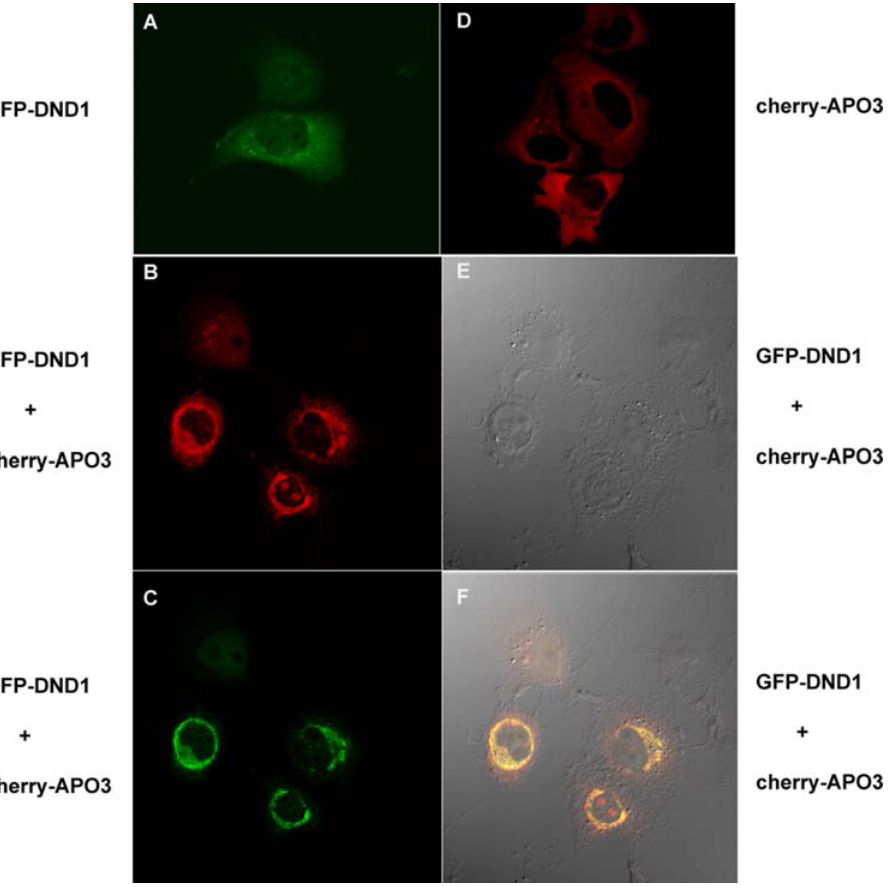
Figure 5. Mouse DND1 and APOBEC3 co-localize to peri-nuclear sites in the cell cytoplasm. (a) COS7 cells were transfected with expression constructs for GFP- Dnd1 for visualization of green fluorescence due to GFP-DND1. Cells were fixed with 2% paraformaldehyde before visualization of fluorescent signal by confocal microscopy. (d) COS7 cells were transfected with expression constructs for mCherry- Apobec3 for visualization of red fluorescence due to mCherry- Apobec3 by confocal microscopy. ( b,c,e and f) COS7 cells were co-transfected with expression constructs for GFP-DND1 and mCherry- Apobec3 . (b) Red fluorescence due to mCherry-APOBEC3 was imaged using red filter (excitation at 548 nm). (c) Green fluorescence due to GFP-DND1 was imaged using green filter (excitation at 488 nm). (f) The merged image of cells co-transfected with GFP- Dnd1 and mCherry- Apobec3 , which shows GFP and mCherry signal co-localized at the peri-nuclear regions of the cells. (e) The DIC (differential interference contrast) image of the cells.